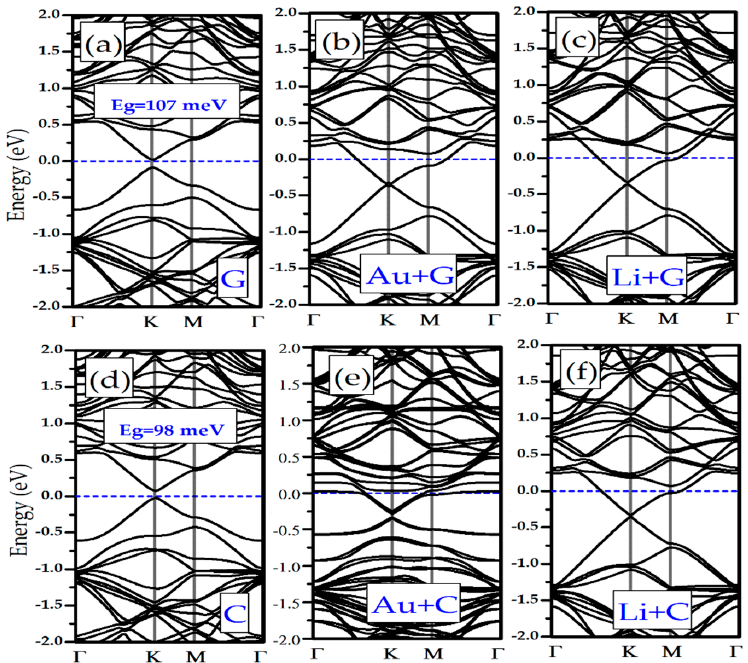
Figure 5. Electronic band structure of ( a ) Silicene/G, ( b ) Au + Silicene/G, ( c ) Li + Silicene/G, ( d ) Silicene/C, ( e ) Au + Silicene/C, and ( f ) Li + Silicene/C.